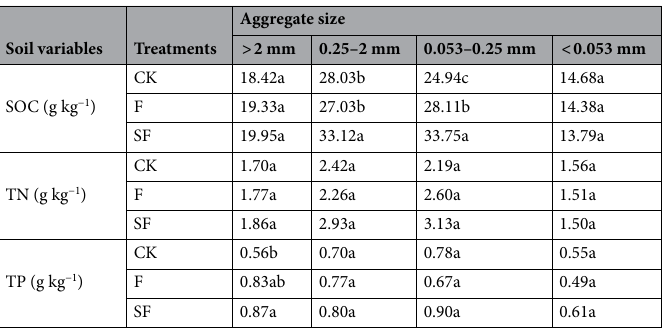
Table 2. Effects of different treatments on SOC, TN, and TP of soil aggregates. Note within columns, means followed by the same letter are not significantly different according to LSD (0.05).